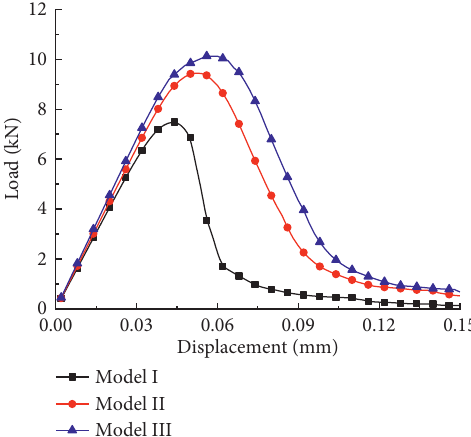
Figure 9: Load-displacement curve of model under static